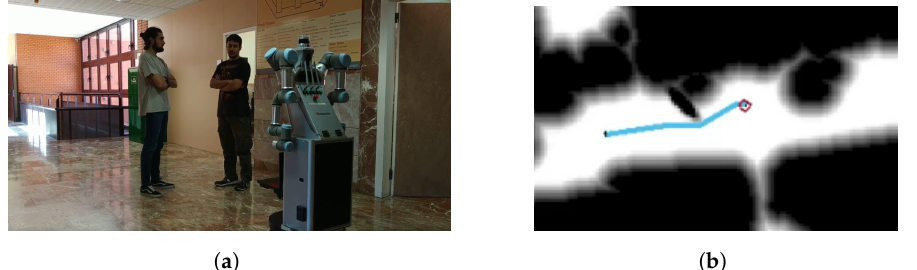
Figure 28. Social navigation example of the robot in a real scenario with two people. ( a ) Initial scenario with two people standing in the initial path; ( b ) path replanning considering the interaction